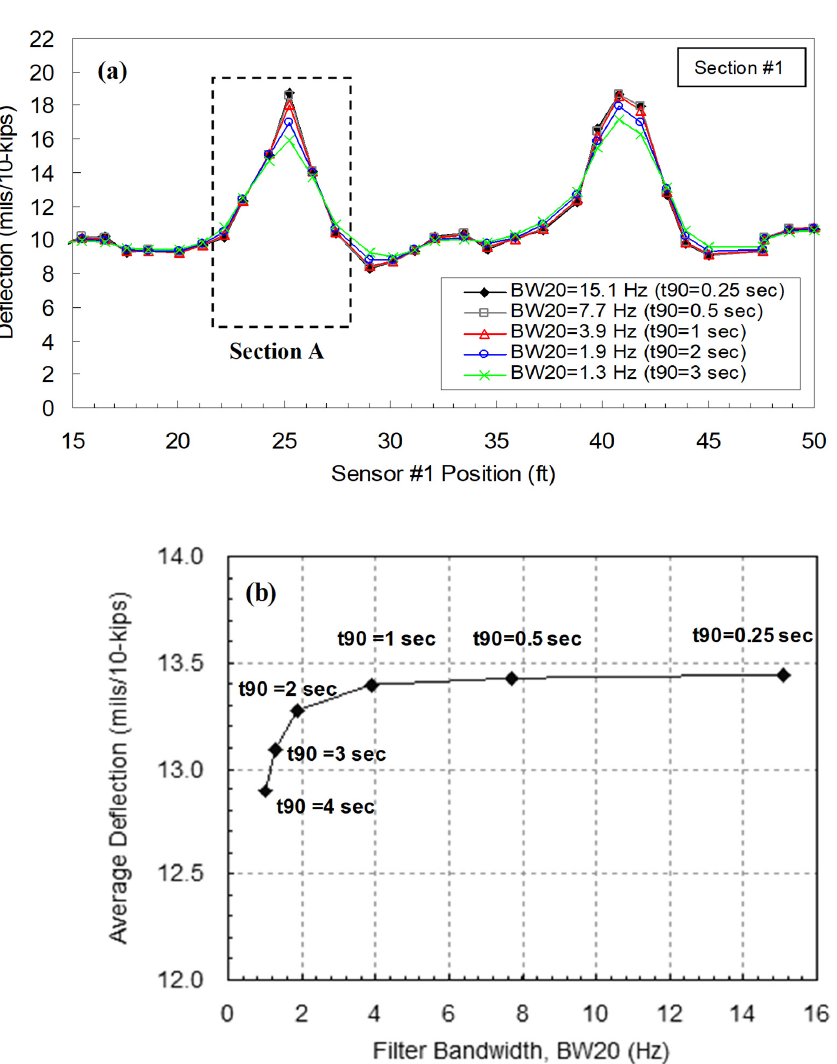
Figure 8. RDD deflection measurement: ( a ) Deflection profiles constructed by various IIR filters with different BW 20 (but fixed FIR filter); and ( b ) relationship between IIR filter BW 20 and average deflection over Section A (showing the effect of filter settling time, t 90 ).